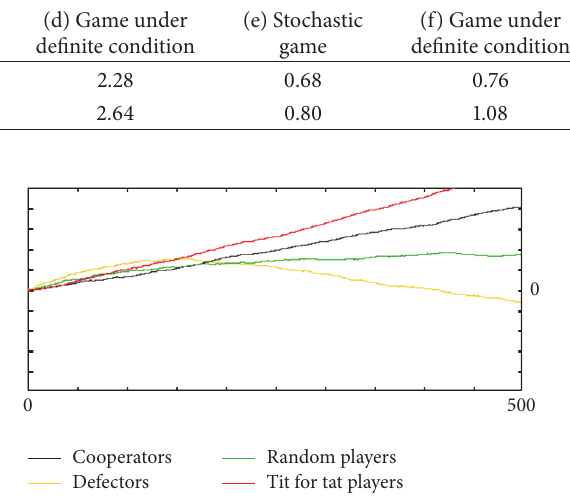
Figure 9: Result of static Prisoner’s Dilemma. Source: http://sys- tems-sciences.uni-graz.at/etextbook/gametheory/prisonersdilem-